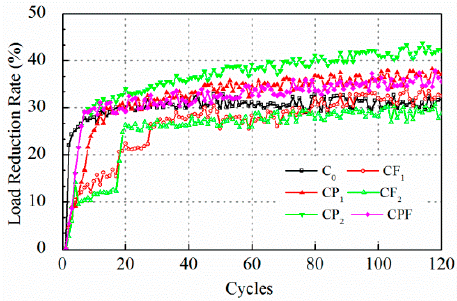
Figure 10. Load reduction rate at 0.1 mm crack opening.